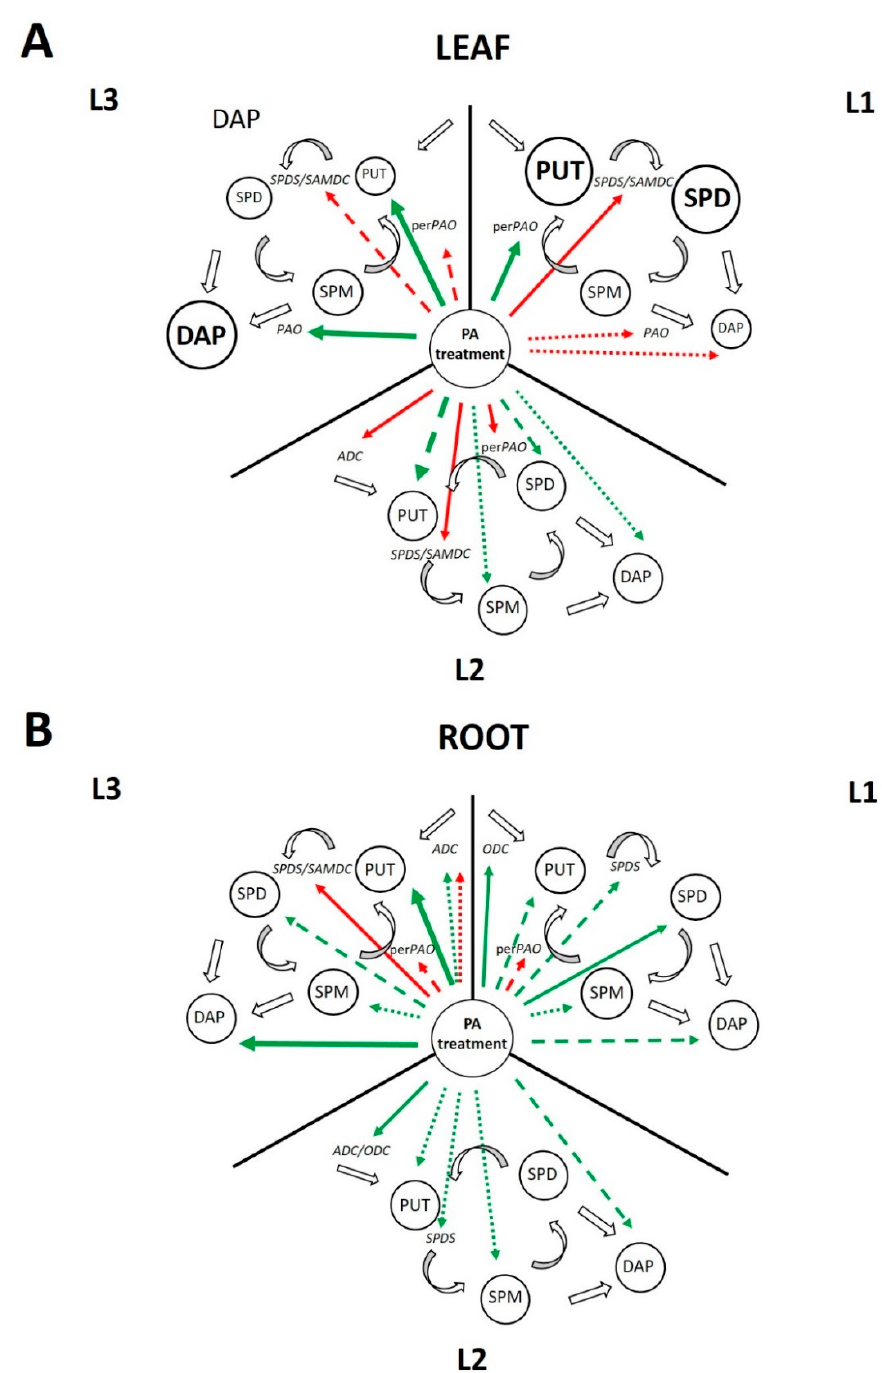
Figure 14. Significant changes in the polyamine metabolism in the leaves ( A ) and roots ( B ) of wheat plants induced by light intensity (L1: elevated, L2: medium and L3: low light conditions). The size of the circles represents light-induced differences in polyamine (PA) contents (PUT: putrescine, SPD: spermidine, SPM: spermine, DAP: 1,3-diaminopropane). The gene expression levels were not influenced by the light intensity alone. Green arrows indicate increasing, while red arrows indicate decreasing effect of the polyamine treatments on polyamine contents or gene expression levels. Solid arrows indicate that all the polyamine treatments have the same effect; dashed arrows show that only 2 of the applied polyamine treatments have the same effect, while dotted arrows represent that only one of the polyamine treatments has influence. Thickness of the arrows indicates the strength of the effects. For details, see the text in the conclusion.